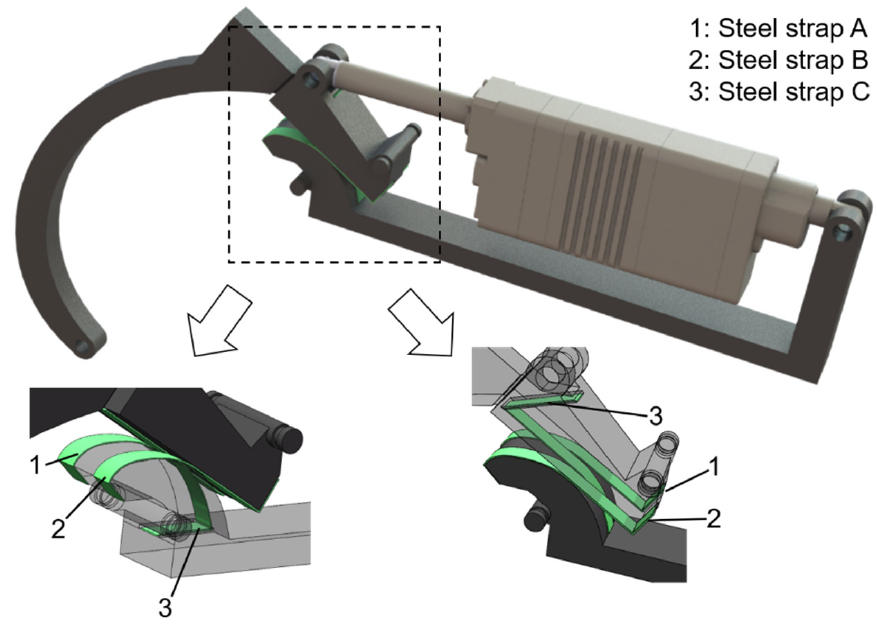
Figure 14. Rolling contact design of the involute surfaces.